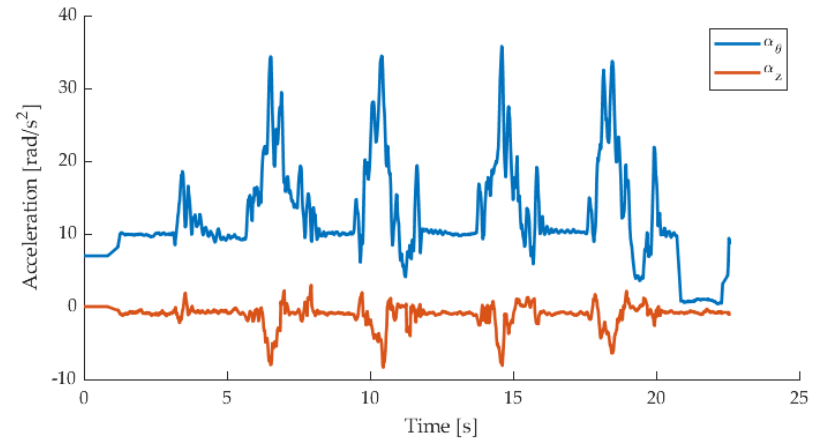
Figure 11. Acceleration data acquired by the IMU on the upper torso mapped as angular acceleration around the instantaneous bending axis α θ and around the backbone axis α z .